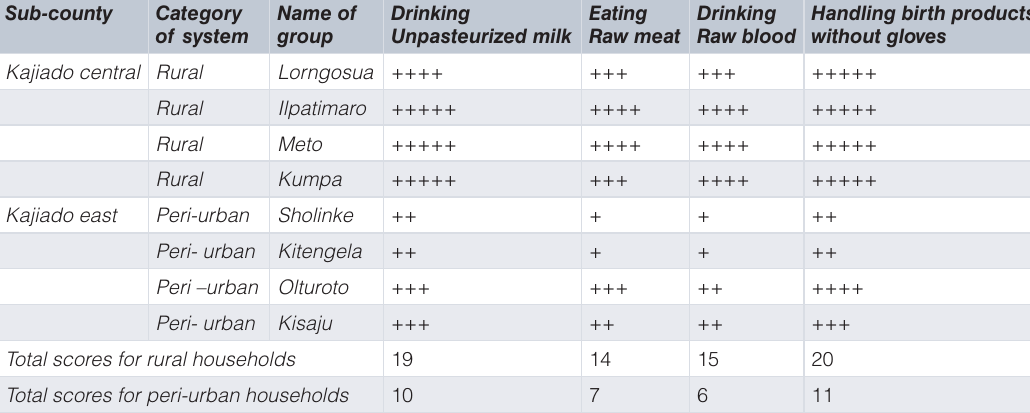
Table 3. Scores allocated per risk factor for contracting brucellosis by pastoralists in